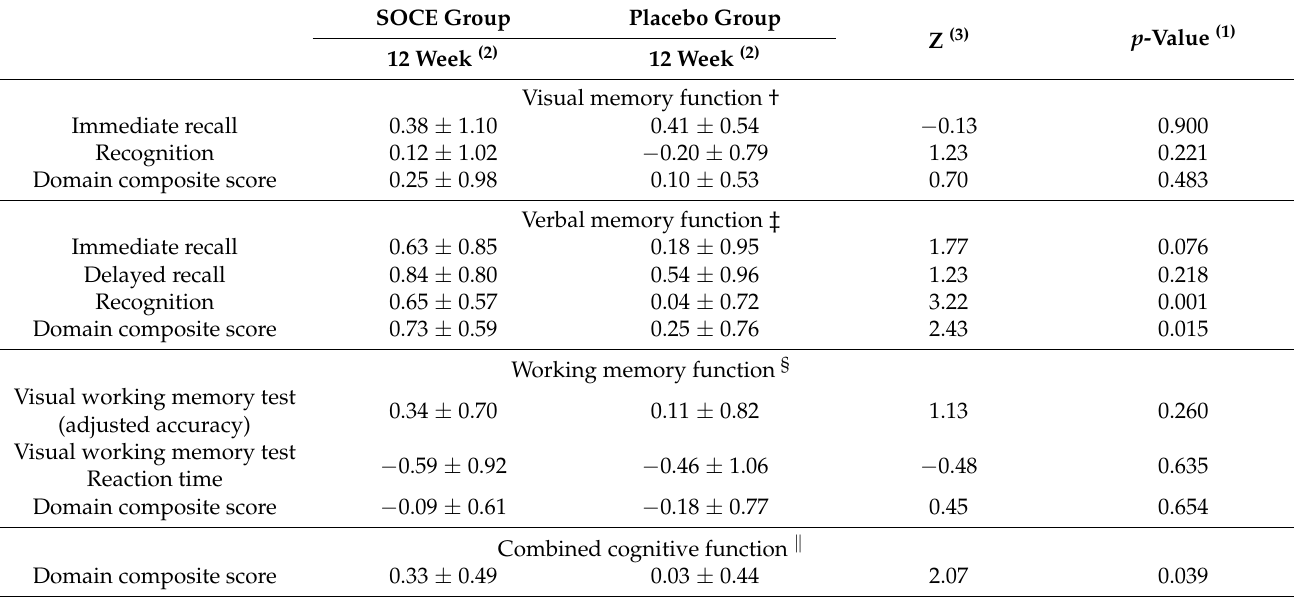
Table 4. Differences in composite Z-scores of each cognitive domain and combined cognitive function between the placebo and SOCE groups. SOCE Group